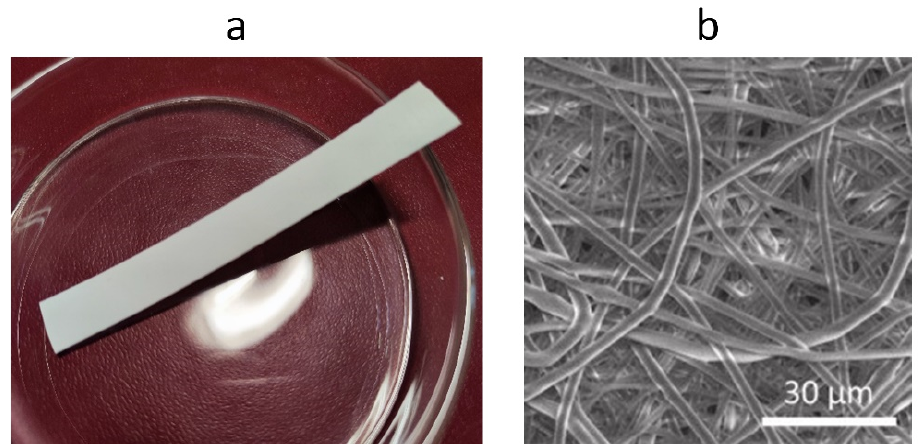
Figure 5. ( a )—PHB film obtained by electrospinning; ( b )—SEM image of PHB film, adapted with permission from [143].